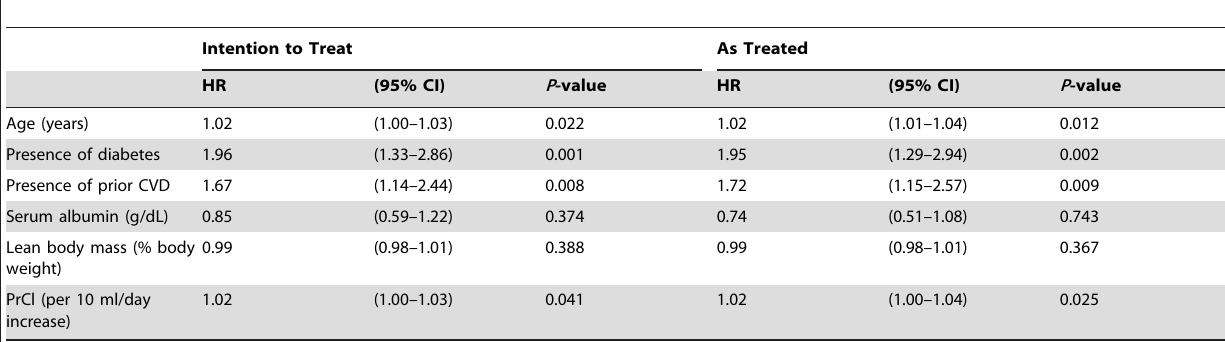
Table 3. Multivariate Cox regression analysis for cardiovascular